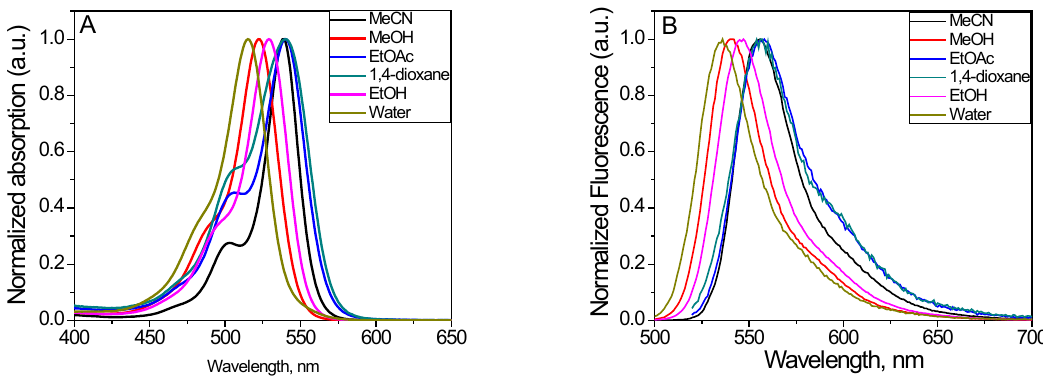
Figure 2: Absorption (A) and fluorescence (B) spectra of compound E in solvents with different polarity.